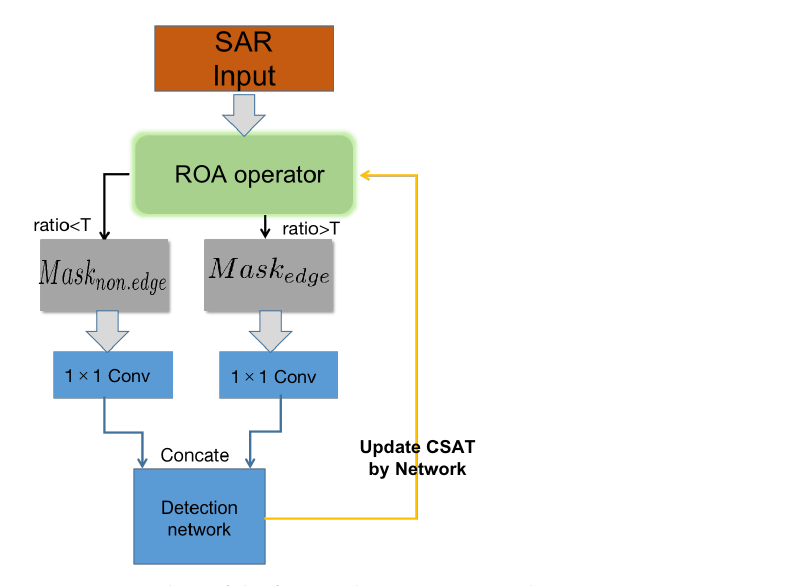
Figure 4. Pipeline of the feature discrimination and image processing